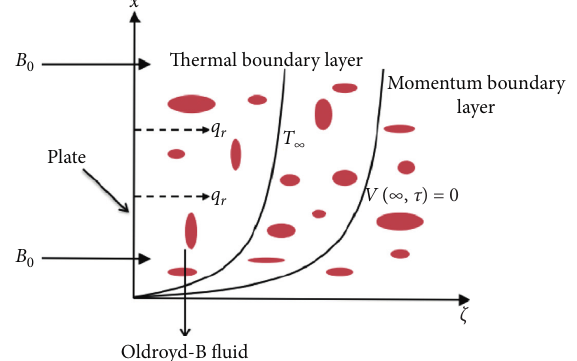
Figure 1: Geometrical presentation of the Oldroyd-B